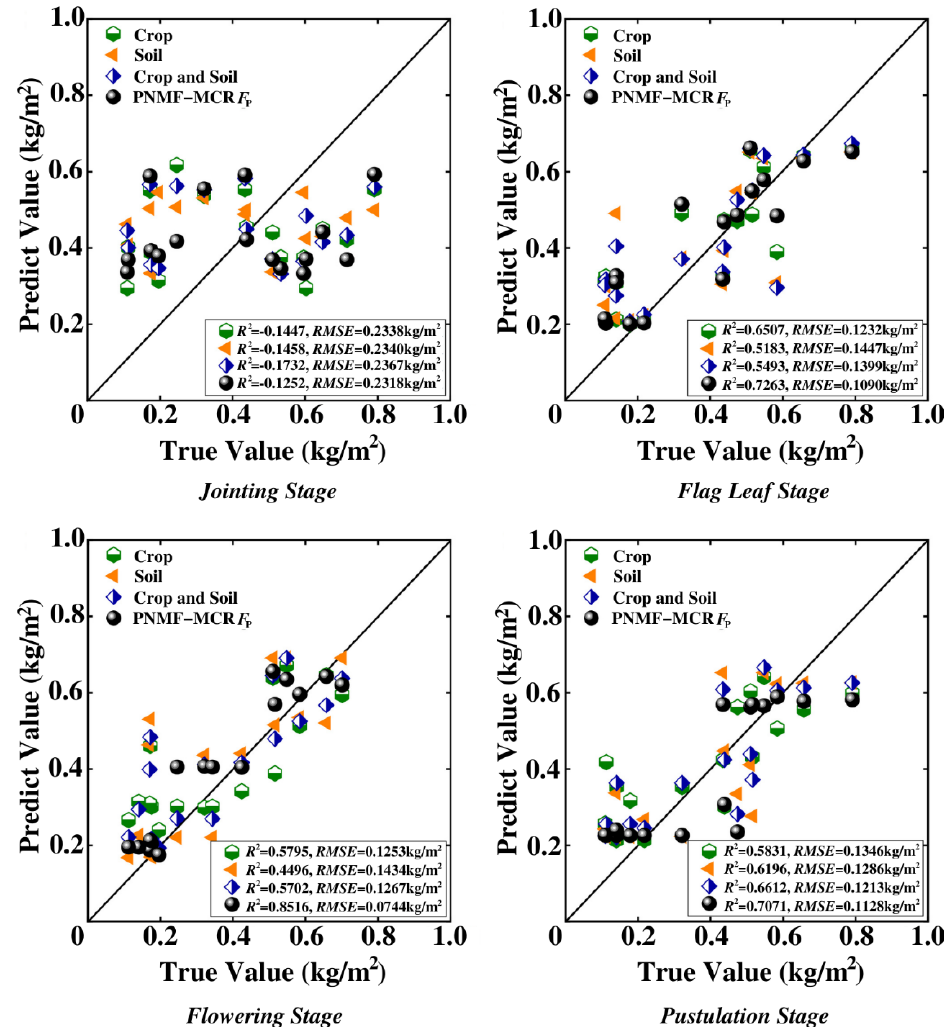
Figure 5. The prediction results of winter wheat yield.